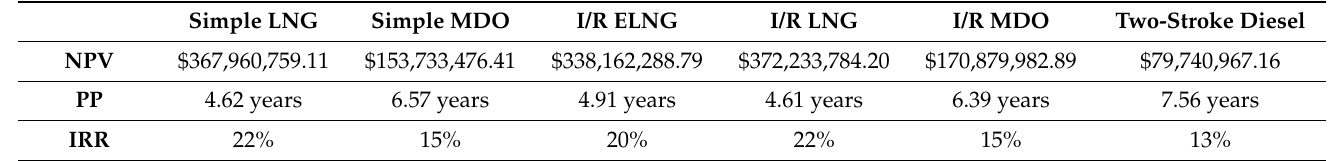
Table 4. Economic results for Route 1.